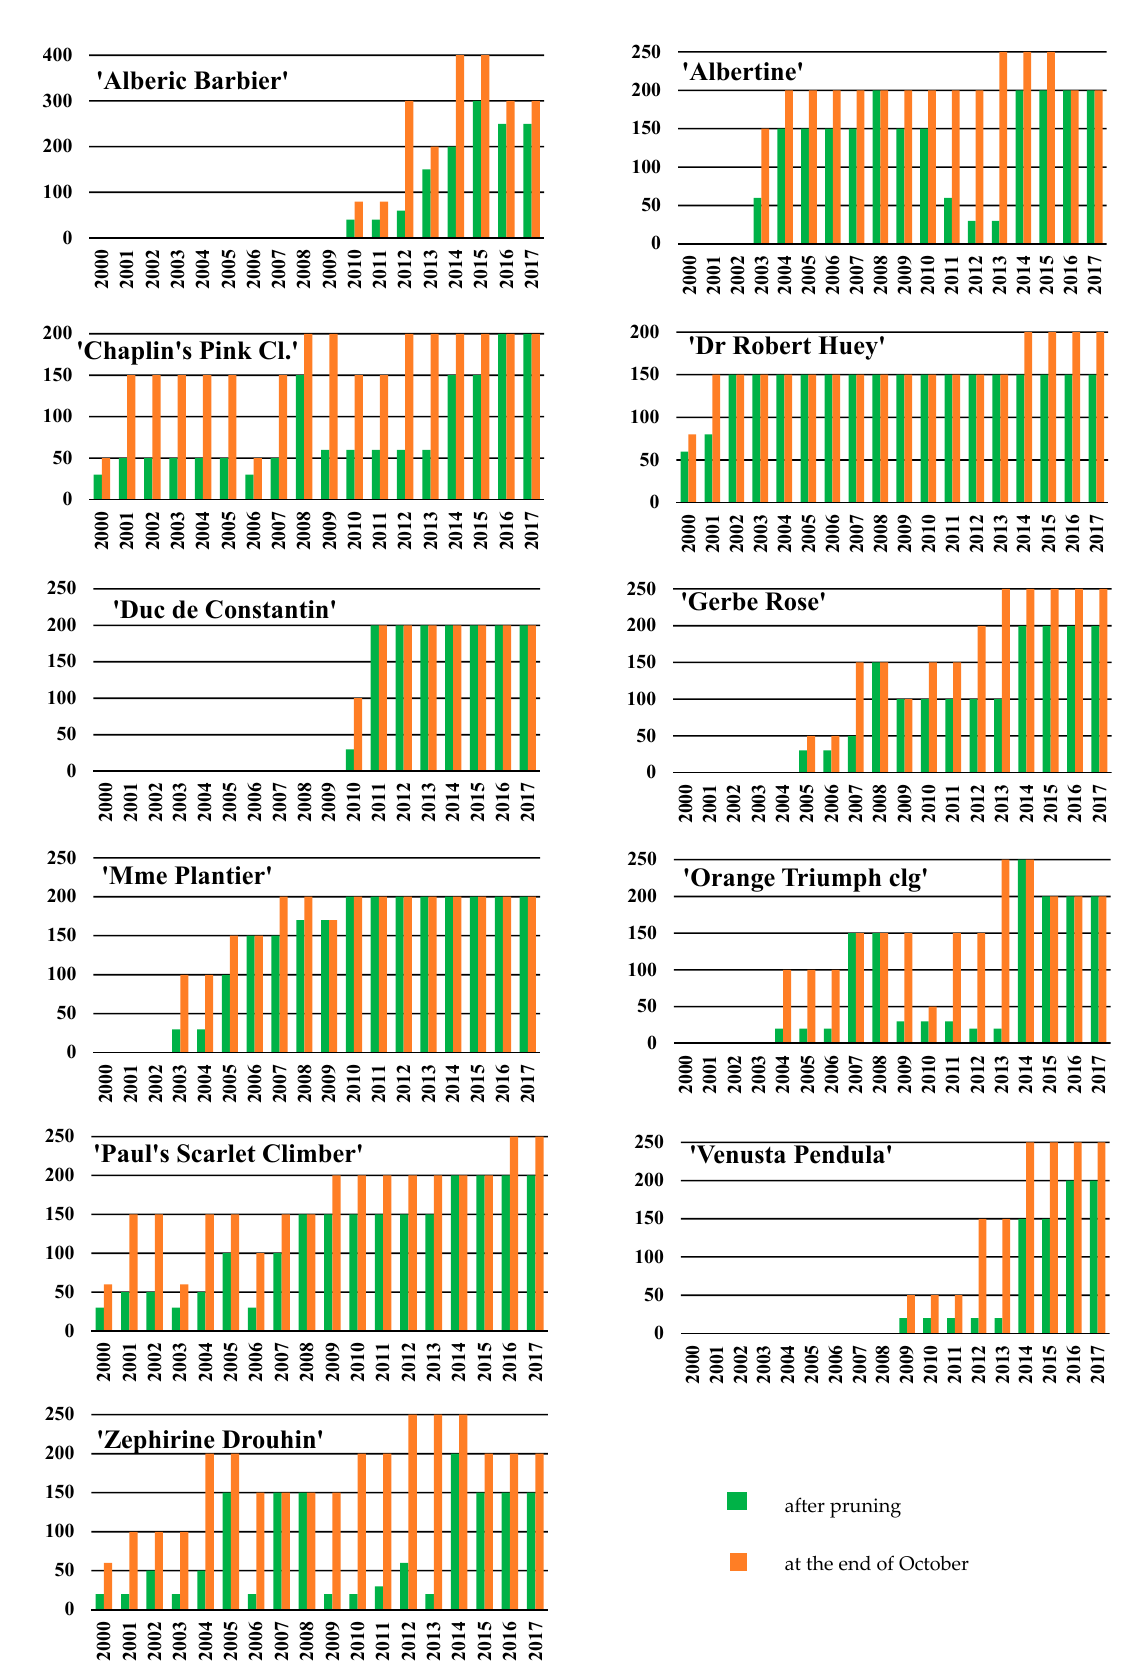
Figure 6. The height (cm) of climber roses after spring pruning and at the end of October in the following years.